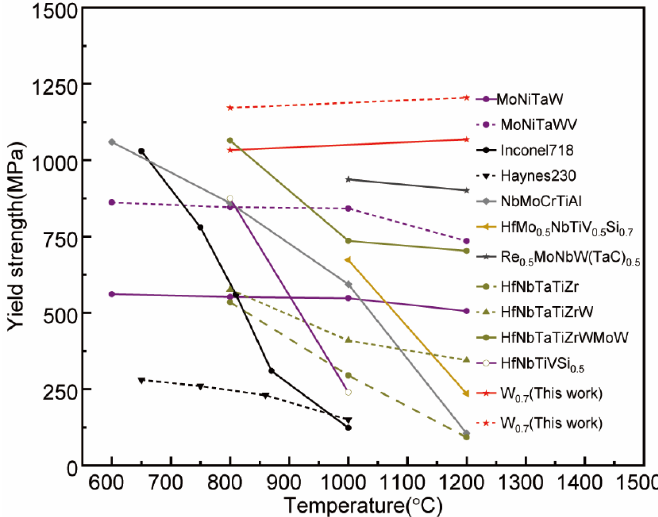
Figure 5. Map of yield strength of various HEA matrix composites and RHEAs including W0.7 and W0.9 composites, the yield strength of which was true [8,9,23,25,26,28–31].